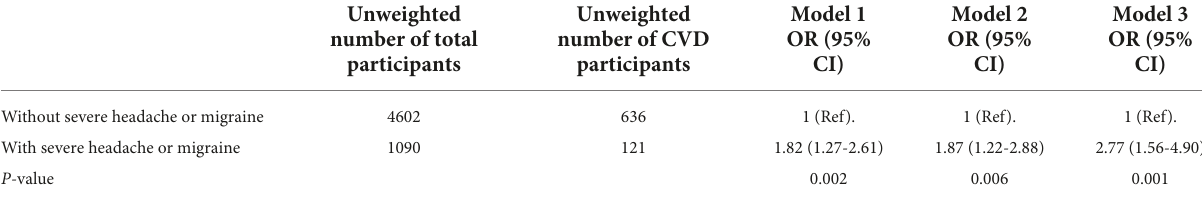
TABLE 2 Association between severe headache or migraine and CVD in the database from NHANES 1999-2004 (weighted).